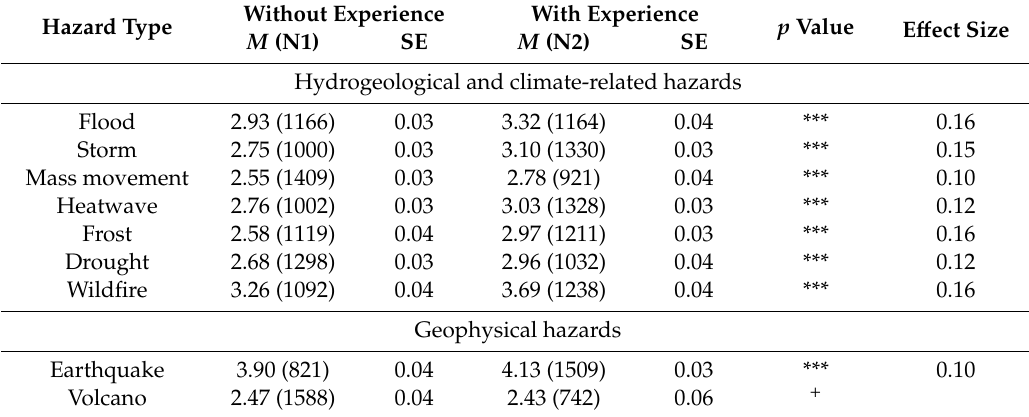
Table 5. Risk perception levels for participants with and without disaster experience.